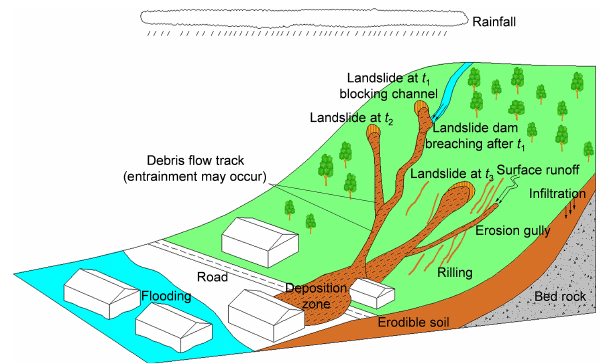
Figure 2. Conceptual model of a rain-induced debris flow and three typical initiation mechanisms of debris flows: bed erosion, transfor- mation from landslide, and dam breach.